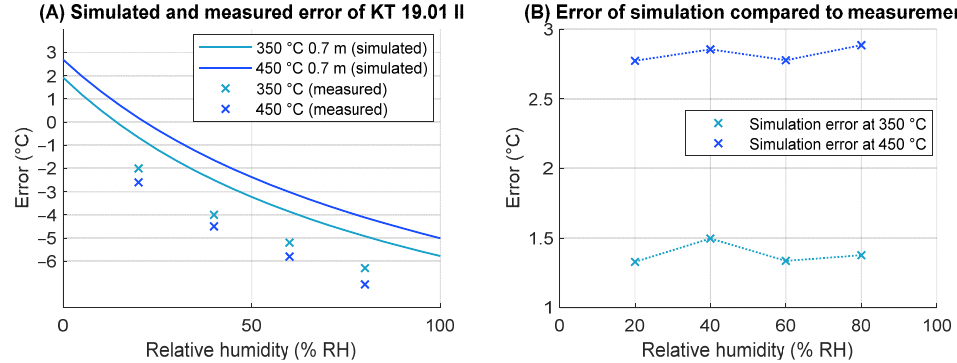
Figure 8. Comparison of experimental and simulated measurements. ( A ) The error represents measurement deviation from reference temperature and ( B ) the error represents discrepancy between the simulated measurement and actual measurement.